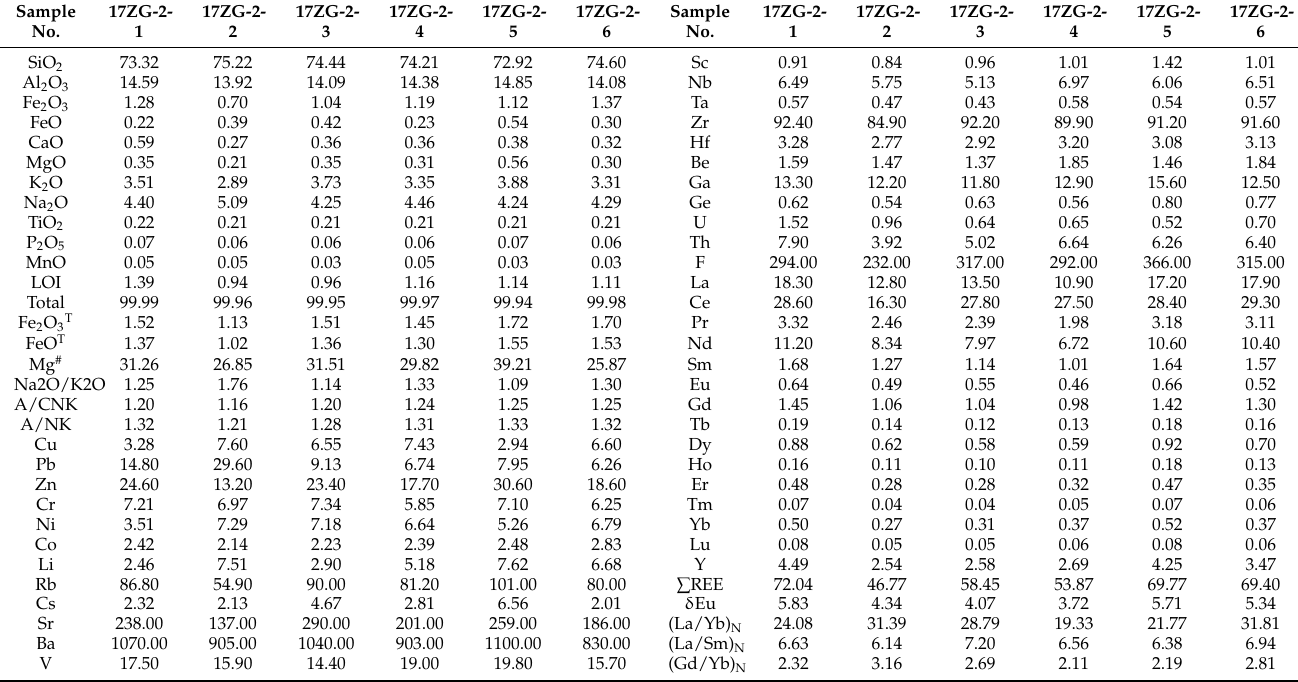
Table 2. Major (wt. %) and trace element (ppm) data from the Zhaojinggou monzogranite, Inner